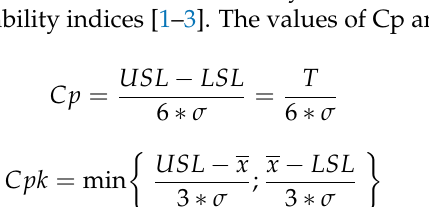
Figure 1. Model of the milling process and dimensional accuracy measurement [27].